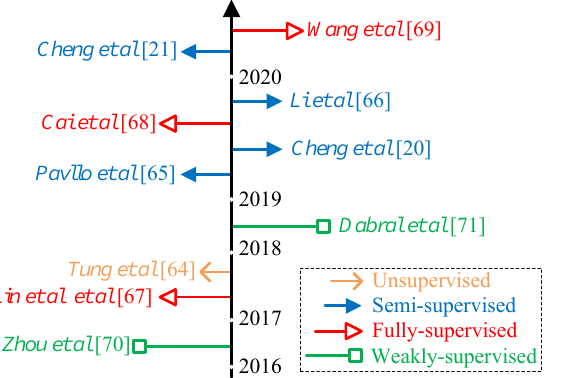
Figure 5. Chronological overview of some of the most relevant video-based single-person 3D pose estimation